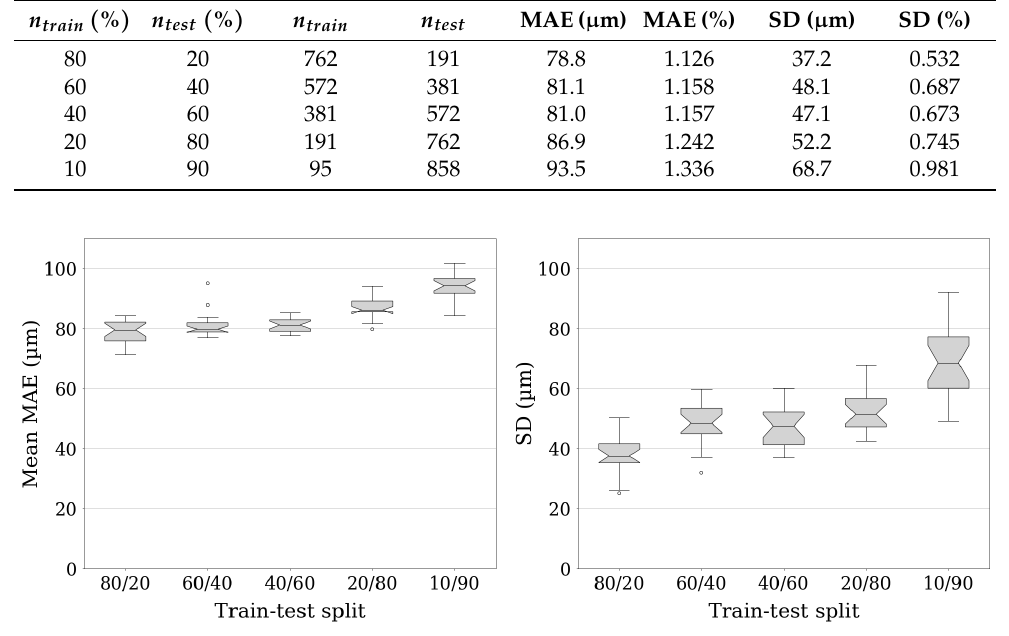
Figure 6. Distribution of the mean MAE and SD of the 3D reconstruction algorithm for different train–test splits. Validation of the U-Net II performance under different proportions of data in the training and testing part for 20 random splits